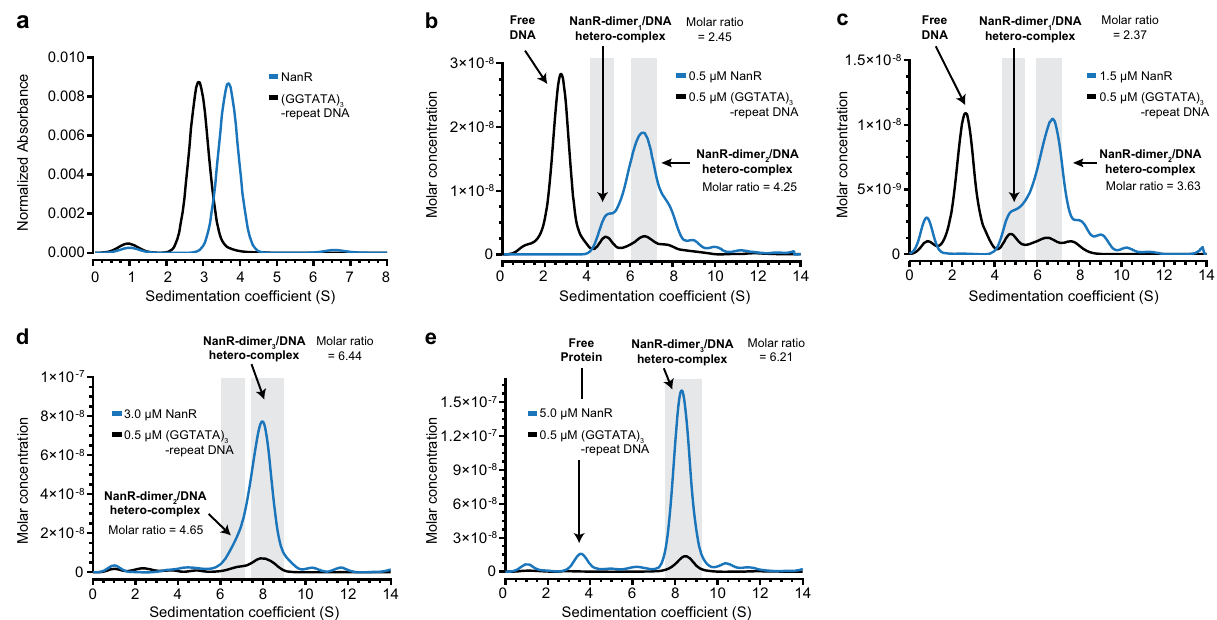
Fig. 3 NanR dimers assemble on the (GGTATA) 3 -repeat operator. a Sedimentation coef fi cient distributions of the NanR (blue) and the (GGTATA) 3 - repeat DNA operator (black) controls, measured individually at 280 and 260 nm, respectively. b – e Deconvoluted sedimentation coef fi cient distributions resulting from the titration of NanR into (GGTATA) 3 -repeat DNA (0.5 µ M): 0.5 µ M NanR ( b ), 1.5 µ M NanR ( c ), 3.0 µ M NanR ( d ), and 5.0 µ M NanR ( e ). A shift in the sedimentation coef fi cient is observed with increasing NanR concentration, consistent with hetero-complex formation. The molar ratio of the integrated peaks (shaded in gray) and the oligomeric state of each hetero-complex is shown. The presence of excess protein free of any co-migrating DNA in e indicates that hetero-complex formation has reached saturation. All plots are presented as g ( s ) distributions with the molar concentration for each interacting partner (protein and DNA) plotted on the y -axis. Hydrodynamic parameters are in Supplementary Table